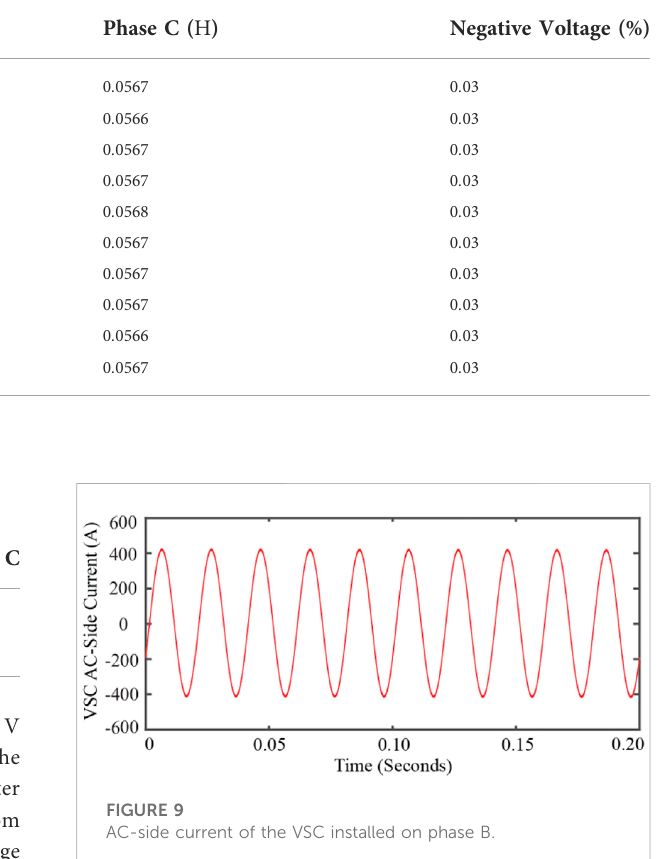
TABLE 3 Analytical compensator values and negative sequence voltage after compensation.